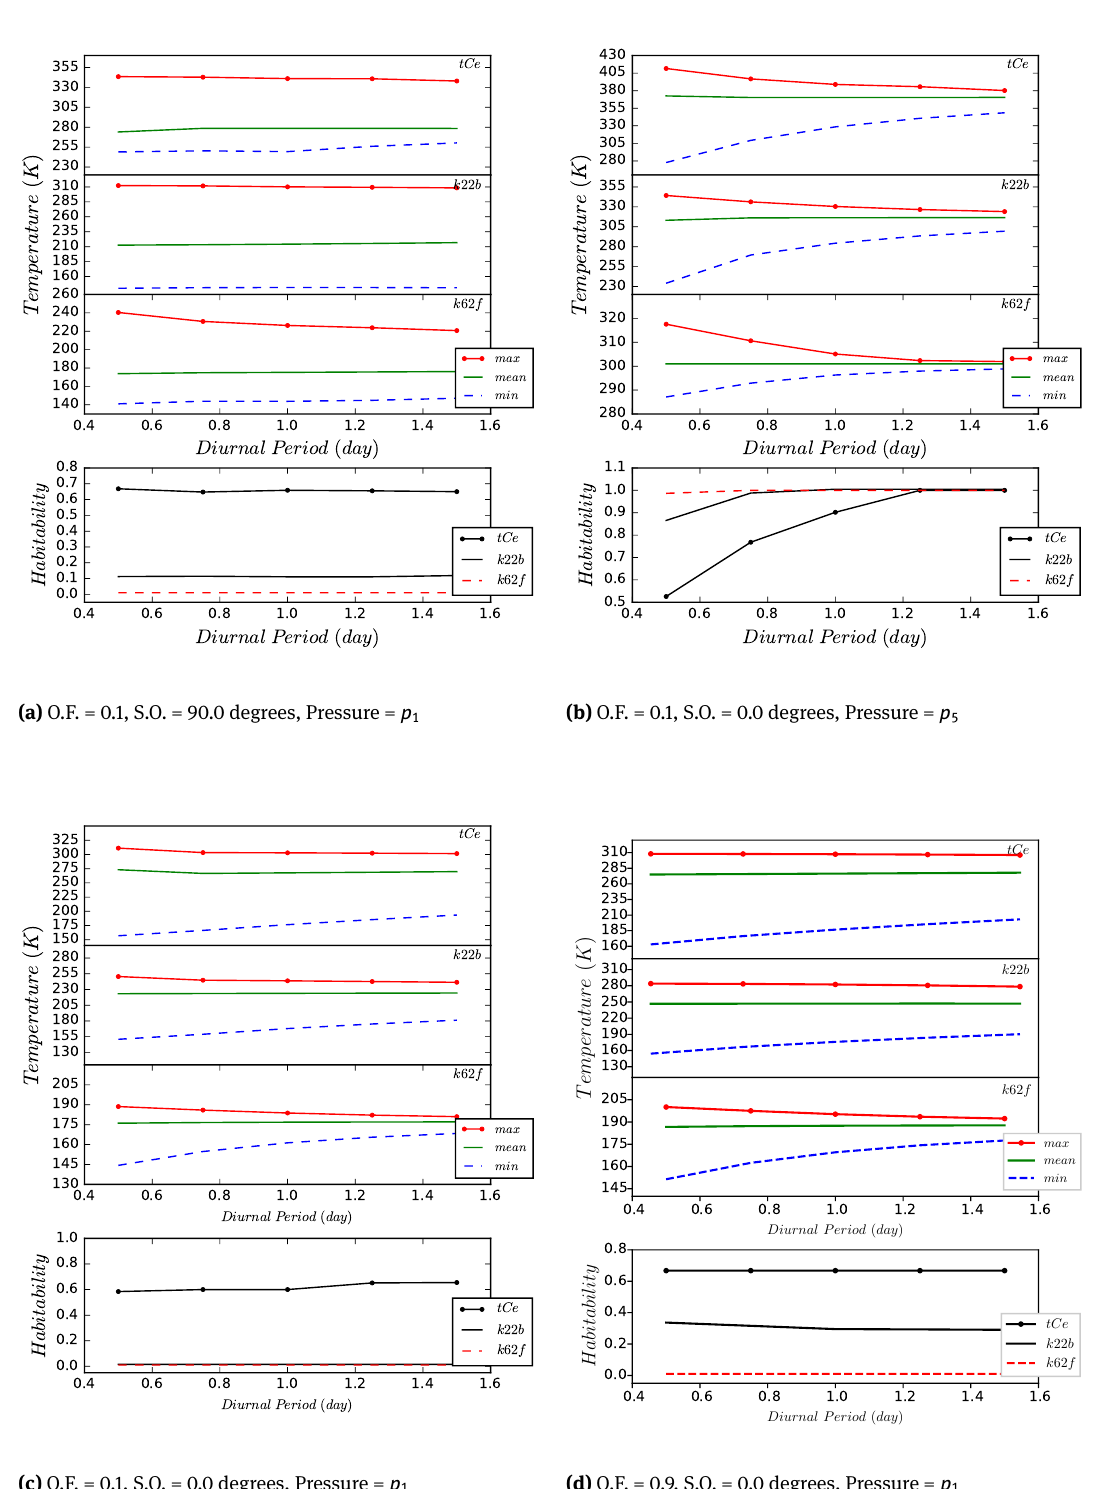
Figure 4. Diurnal period varies; for planet τ Ceti e (tCe), Kepler-22b (k22b) p 1 = 0.1 atm , p 5 = 1.3 atm ; and for Kepler-62f (k62f) p 1 = 0.5 atm , p 5 = 4.5 atm